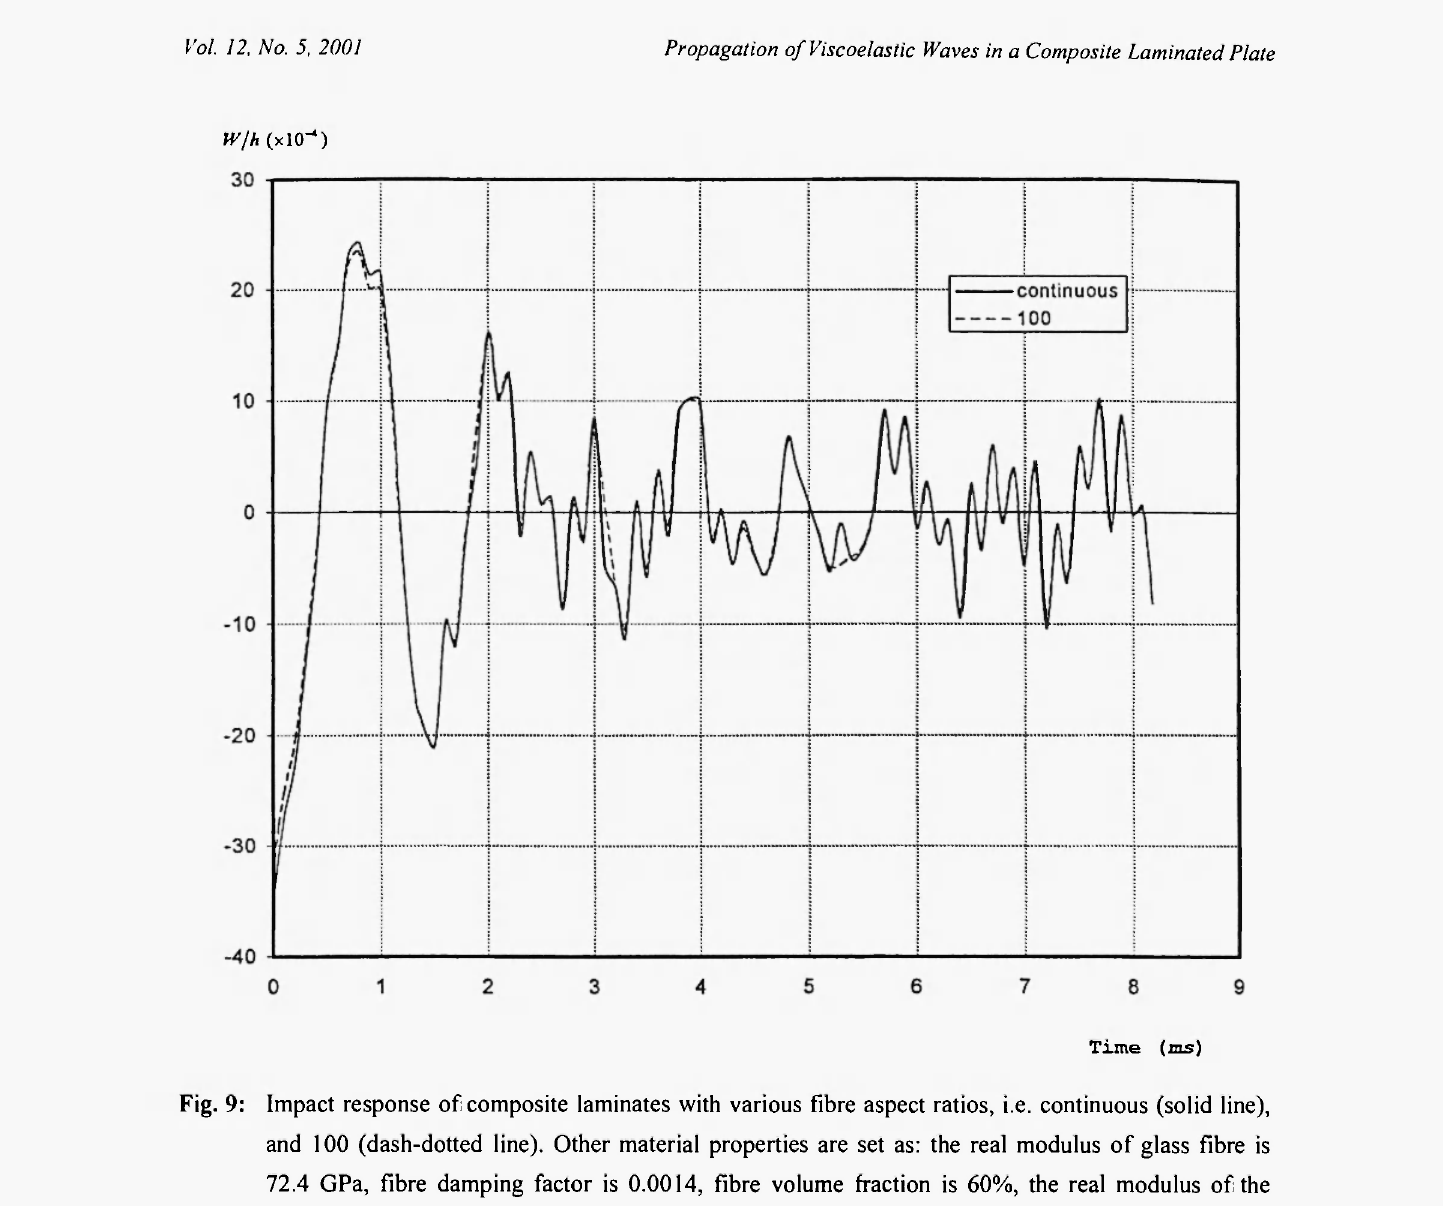
Fig. 9: Impact response of composite laminates with various fibre aspect ratios, i.e. continuous (solid line), and 100 (dash-dotted line). Other material properties are set as: the real modulus of glass fibre is 72.4 GPa, fibre damping factor is 0.0014, fibre volume fraction is 60%, the real modulus of the matrix is E mr = 1158 (1 + 1 0 0 / ) ° w i t h / as frequency, and damping factor of the matrix is